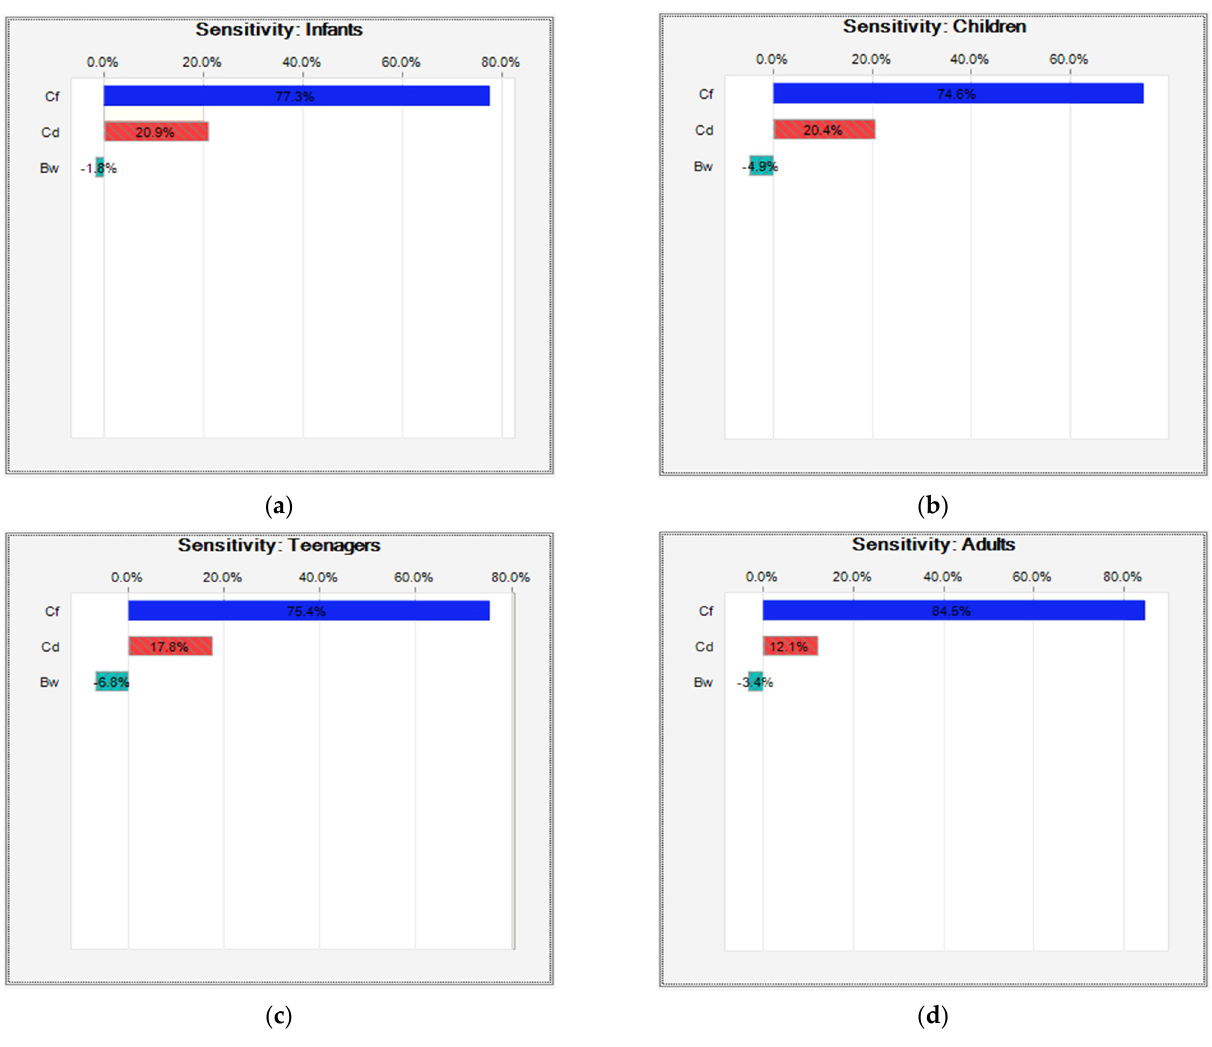
Figure 7. HQ Histogram: ( a ) Infants; ( b ) Children; ( c ) Teenagers; ( d ) Adults. The sensitivity analysis results showed that nitrate concentration and water consumption positively influenced health risk (Figure 8). In contrast, the toxicity of nitrate was adversely affected by body weight. Climate conditions and physical activities can increase the nitrate non-carcinogenic risk due to enhanced water consumption. Hence, the result may be an increased risk of nitrate exposure from drinking water.